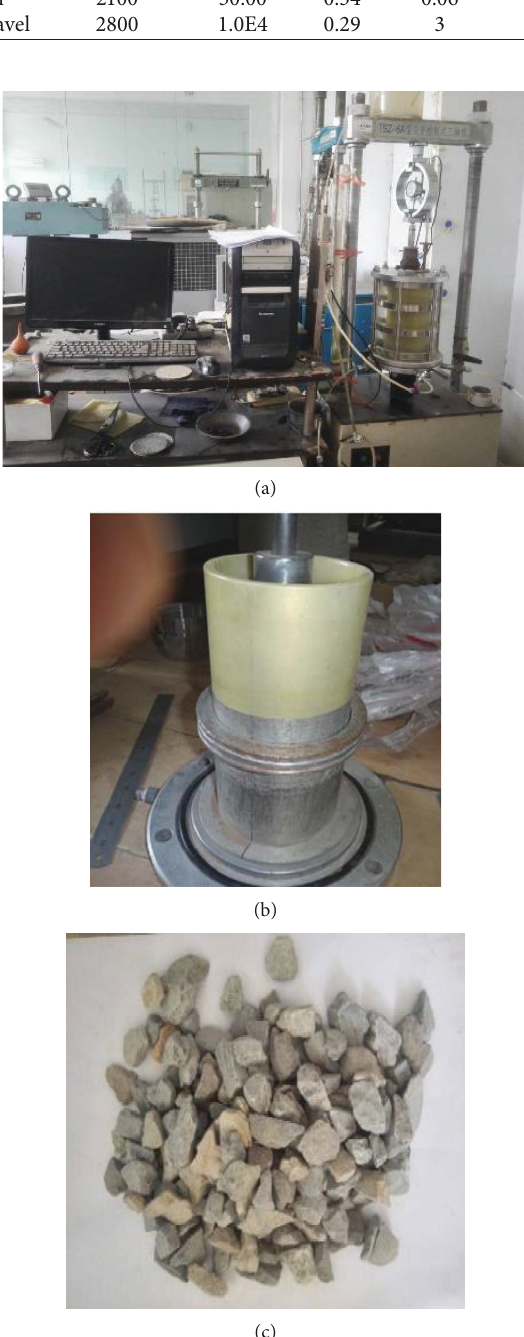
Figure 1: Triaxial test device for soil-rock mixture. (a) Medium triaxial test system. (b) Medium triaxial test sampler. (c) Gravel used in